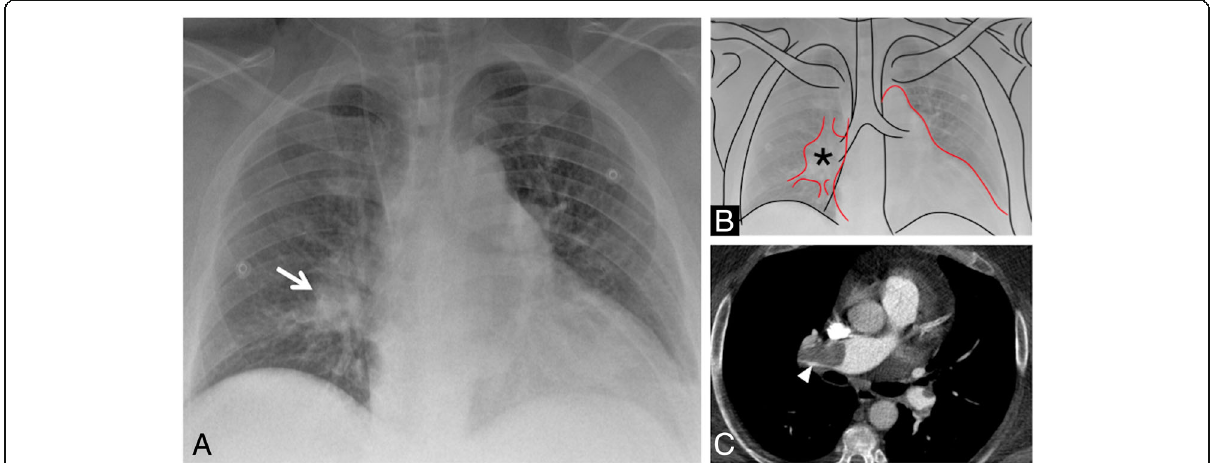
Fig. 13 Fleischner sign. The “ Fleischner sign ” consists of a prominent central pulmonary artery upstream of cutoff (white arrows in a , black asterisk in b ). It is frequently caused by a large embolus into the central pulmonary artery, as well depicted on axial CT image of the same patient ( c , white arrowhead)